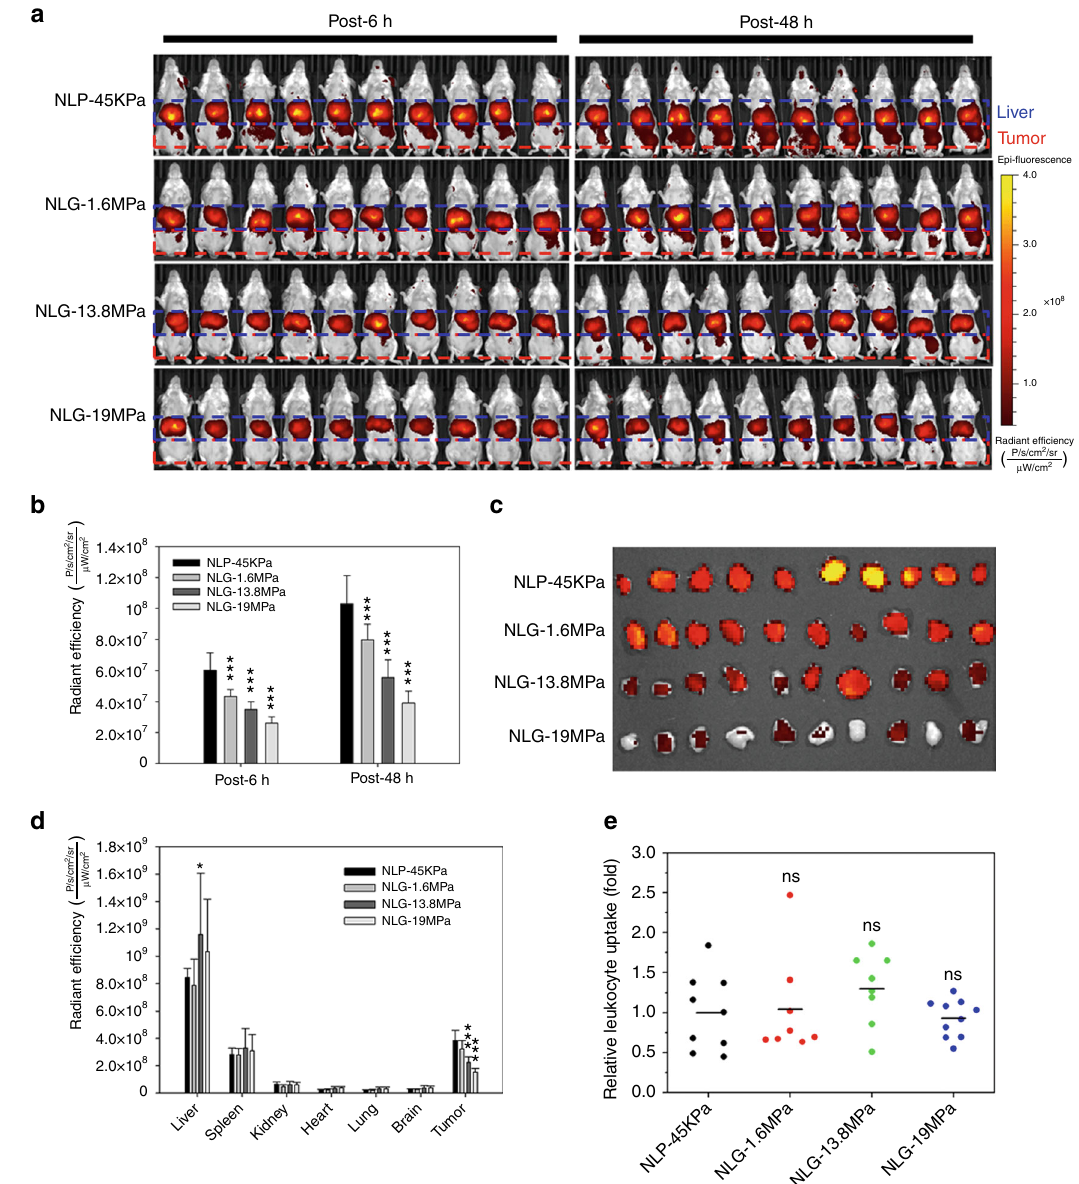
Fig. 5 Particle elasticity regulates in vivo tumor uptake. a In vivo NIR fl uorescent images of mice at post-6h and -48h after i.v. administration of DiR-labeled NLP-45KPa, NLG-1.6MPa, NLG-13.8MPa, and NLG-19MPa ( n = 10 for each group). b In vivo tumor accumulation of synthesized NLP-45KPa and NLGs was quanti fi ed by fl uorescent intensity. c Ex vivo NIR fl uorescent images of excised tumors at post 48 h. d The biodistribution of NLP-45KPa and NLGs in organs (liver, spleen, lung, kidney, heart, and brain) and tumors was quanti fi ed by their fl uorescent intensity at post-48h ( n = 10 for each group). e Uptake of NLP-45KPa and NLGs by mouse leukocytes was quanti fi ed by fl ow cytometry ( n = 8 – 10 for each group). ns not signi fi cant, * P < 0.05, ** P < 0.01, *** P < 0.001. The mean values and error bars are de fi ned as mean and S.D., Methods mL DMSO:EtOH (7:3, v:v). This solution was added dropwise through a syringe Cell culture . Human breast cancer MDA-MB-231 and MCF7 cells, human non- (gauge size 20) to a solution of 9mL PBS or 1mg/mL sodium alginate aqueous solution under vigorous stirring. The resulting lipogel NP solution went through neoplastic mammary epithelial MCF10A cells, murine breast cancer 4T1 cells, and fi ve freeze-thaw cycles and was repetitively extruded through a 200 nm poly- human microvascular endothelial cells (HMVECs) were purchased from American carbonate track etch nanoporous membrane for fi ve times. The resulting NLP or Type Culture Collection (ATCC, Manassas, VA, USA). MDA-MB-231 and MCF7 NLG solution was dialyzed in FLOAT-A-LYZER G2 dialysis tubing (MWCO 1,000 cells were cultured in DMEM, 4T1 cells in RPMI-1640 Medium, MCF10A cells in kDa) in deionized H 2 O overnight at 4 °C. After dialysis, an ionic crosslinking DMEM/F12 (1:1), and HMVECs in Lonza EGM-2-MV with recommended sup- solution containing (0 – 10 mM CaCl 2 ) was added dropwise to NLG solution (1:1, v: plements, respectively. All cells were cultured in a 37 °C humidi fi ed incubator with v) in order to crosslink the sodium alginate monomers within the liposomal 5% CO 2 . membrane. After 1h incubation, the resulting NLG solution was further dialyzed in FLOAT-A-LYZER G2 dialysis tubing (MWCO 1000 kDa) in PBS for 24h at 4 °C. In drug encapsulation experiments, FITC-dextran and siRNA-encapsulating NLP Preparation of NLP and NLGs . NLP and NLGs were prepared using extrusion and NLGs were prepared using the similar procedure except adding 1mg/mL method with modi fi cations 20 – 22 . Overall, 50 μ mol 1,2-dioleoyl-sn-glycero-3-phos- FITC-dextran or 15 μ g/mL siRNA to the 9mL PBS or alginate solution. In the phocholine (DOPC) was dried under a stream of nitrogen gas and stored in a cellular and tumor uptake experiments, OG488-DHPE or DiR-labeled NLP and vacuum desiccator overnight, the resulting phospholipid fi lm was resuspended in 1